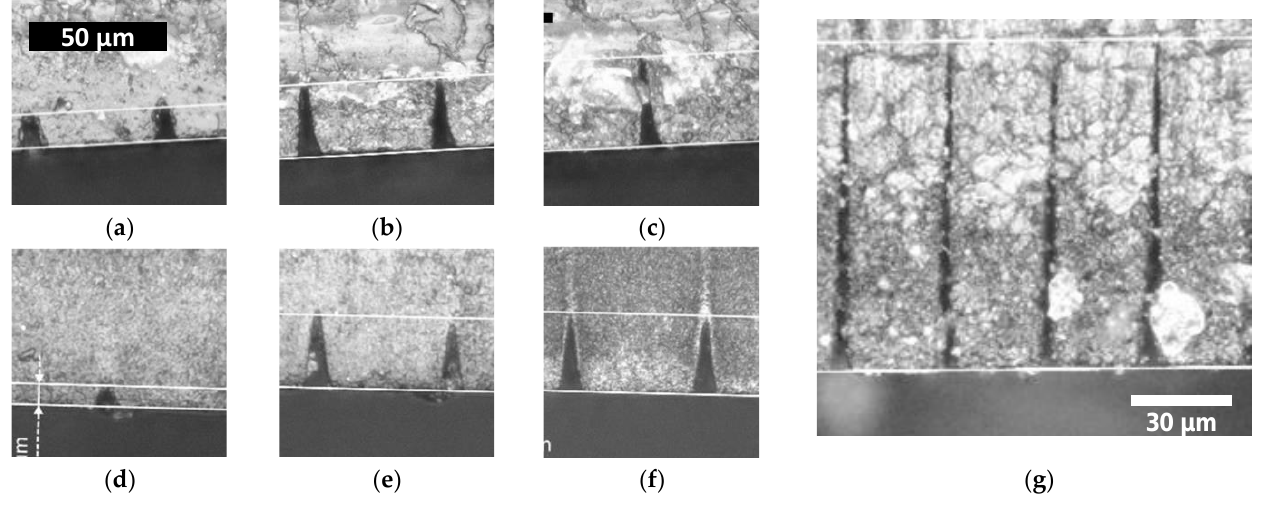
Figure 2. Comparison of SEBS G1650 ( a – c ) and NBR H-AT-68 ( d – g ) for 0.45 µJ pulse energy. The number of repetitions is increased from left to right from 5 over 15 to 20 and 70 for ( g ).